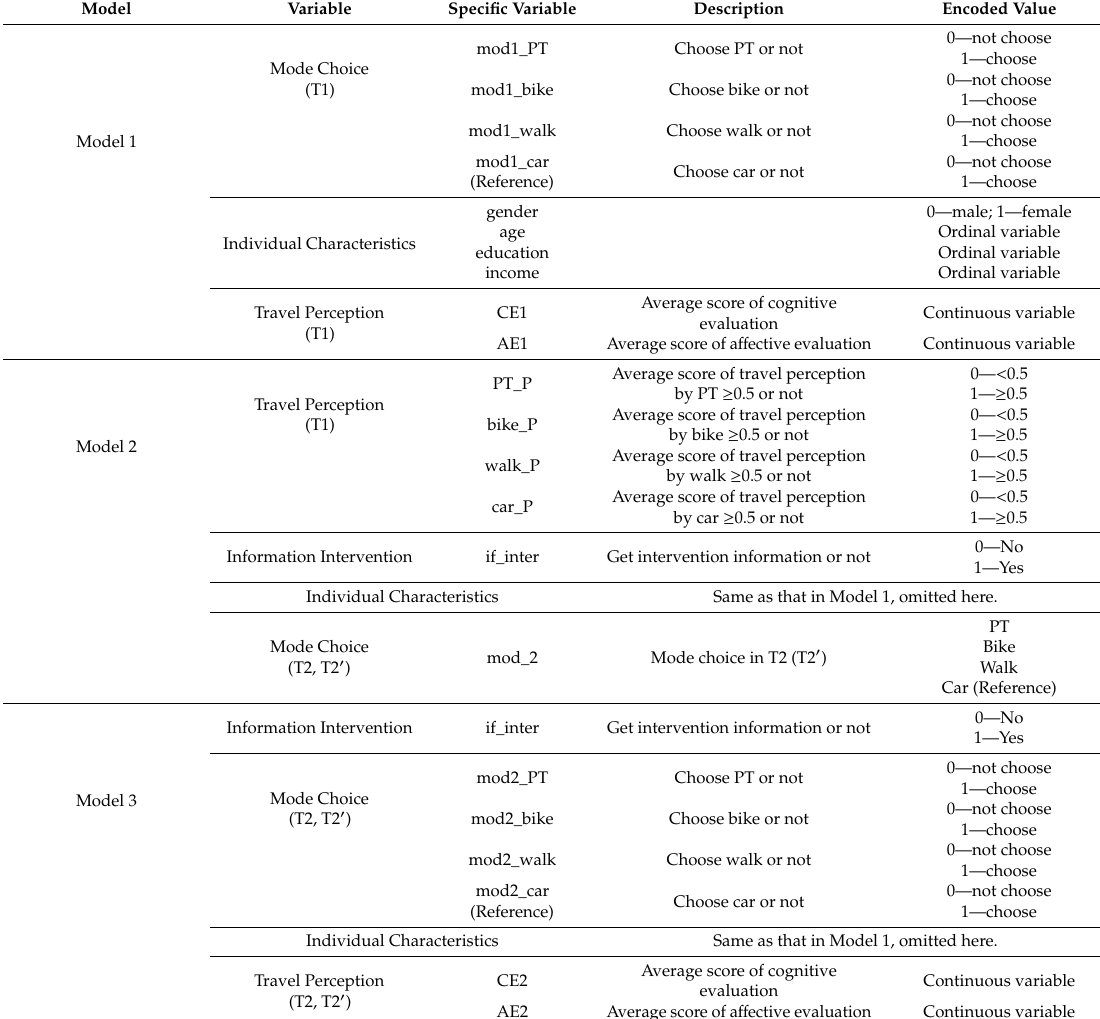
Table 6. Variable descriptions of information intervention process